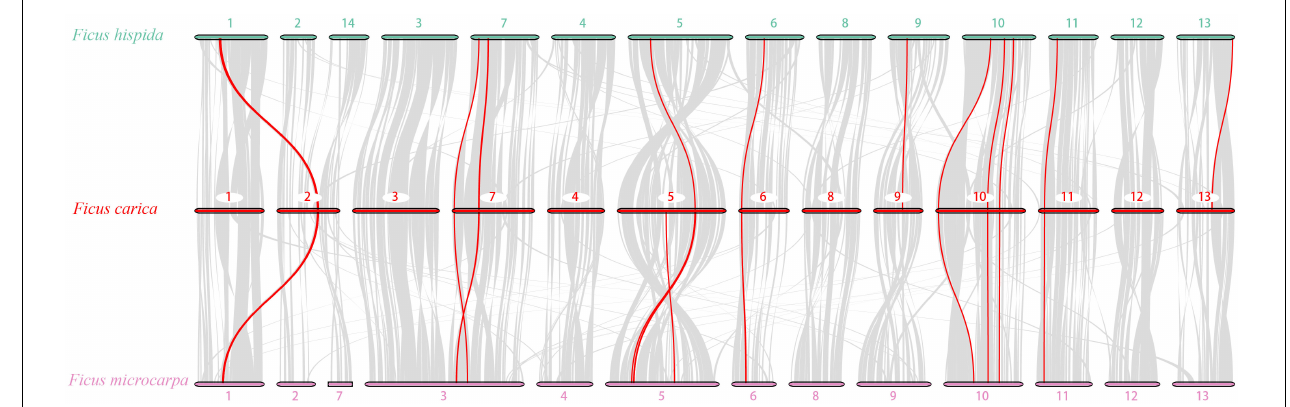
FIGURE 7 | Genome synteny analysis of F. carica with F. hispida and F. microcarpa . Gray lines in the background indicate the collinear blocks among F. carica and F. hispida and F. microcarpa ; red lines highlight syntenic PLCP pairs.